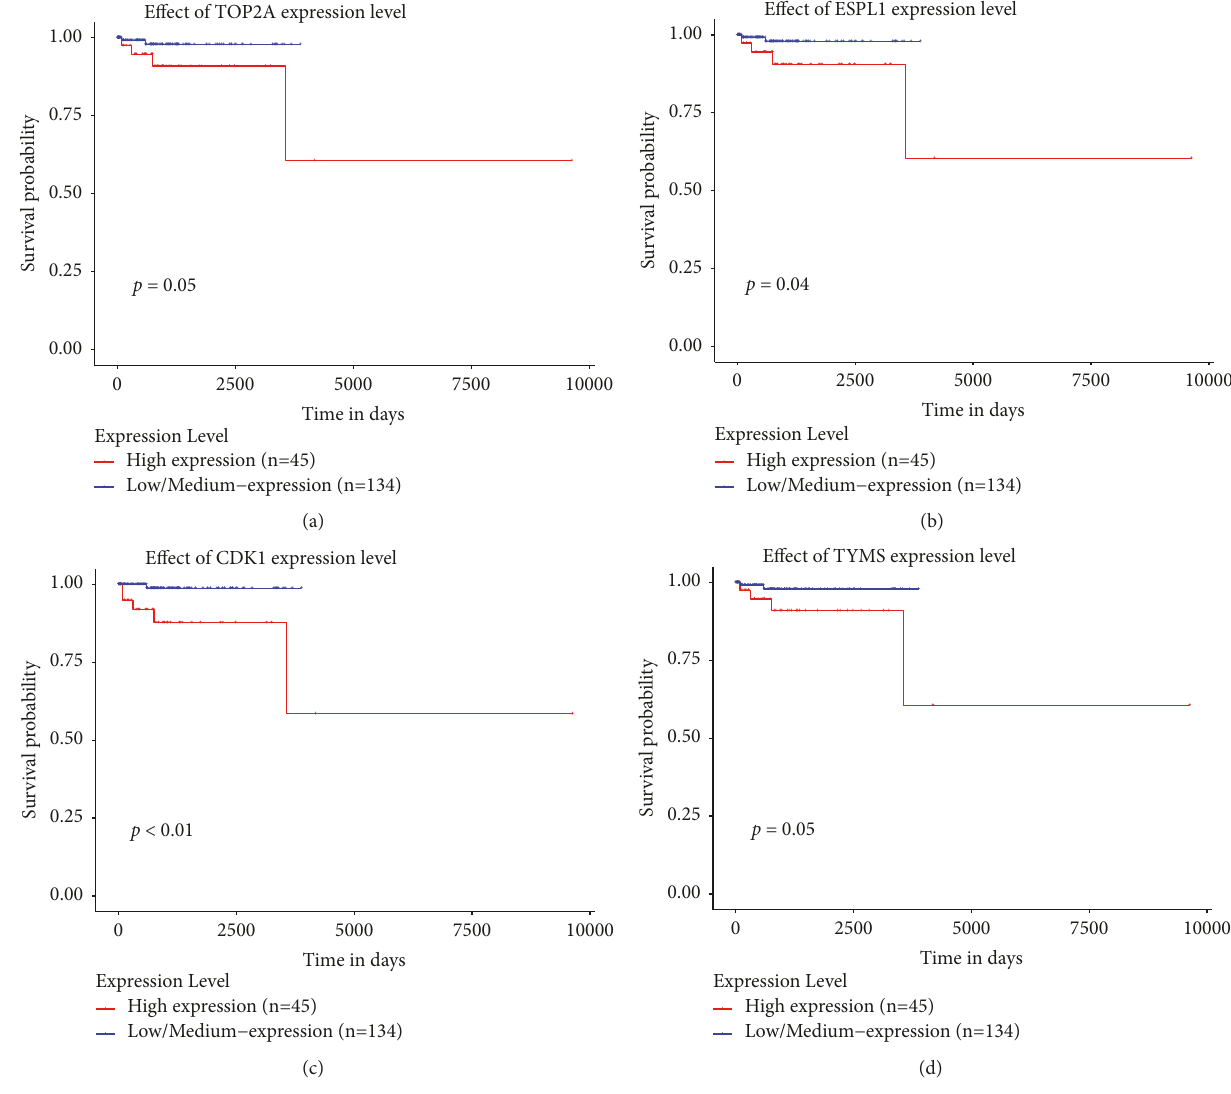
Figure 7: Whentheidentified genes were analyzed in UALCAN, overall survivalratein TCGAwas considerably significantly with four genes: (a) TOP2A , (b) ESPL1 , (c) CDK1 , and (d) TYMS